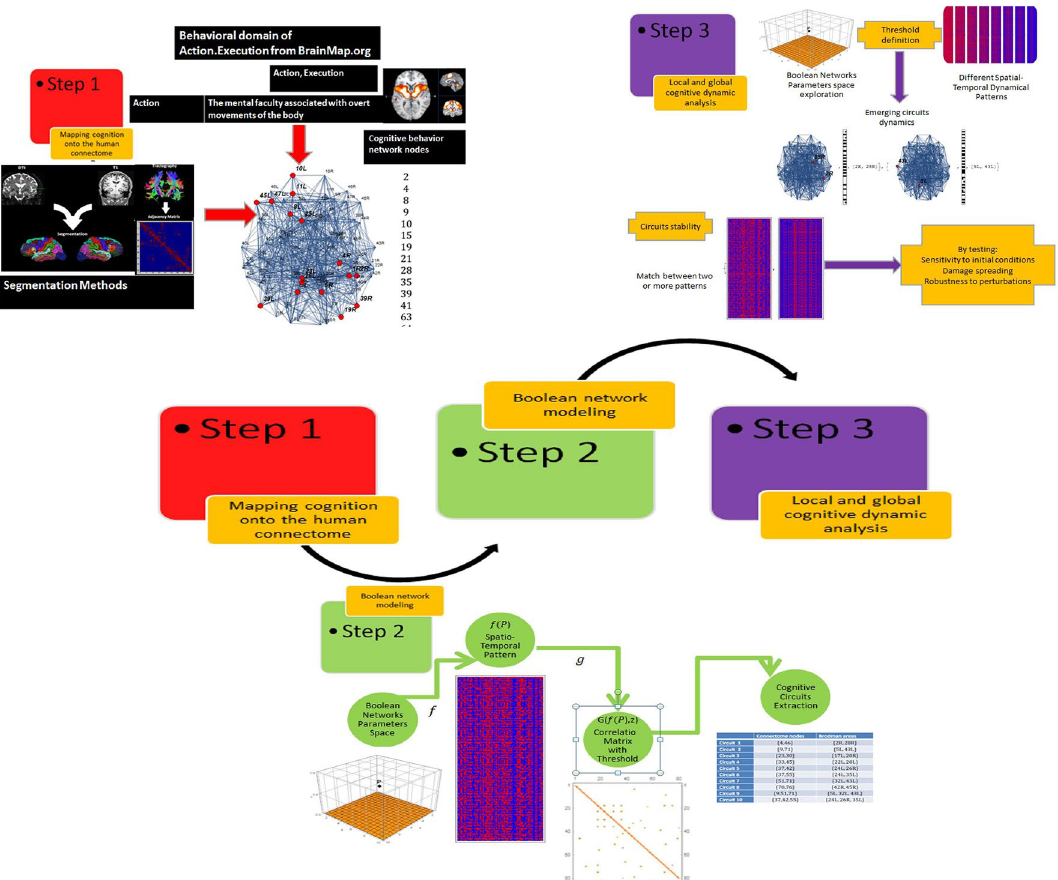
Figure 1. The three-step pipeline that has been used foresees the mapping of cognition onto the human connectome, the Boolean Network modeling, the circuits identification and the cognitive networks dynamical analysis at the local and the global